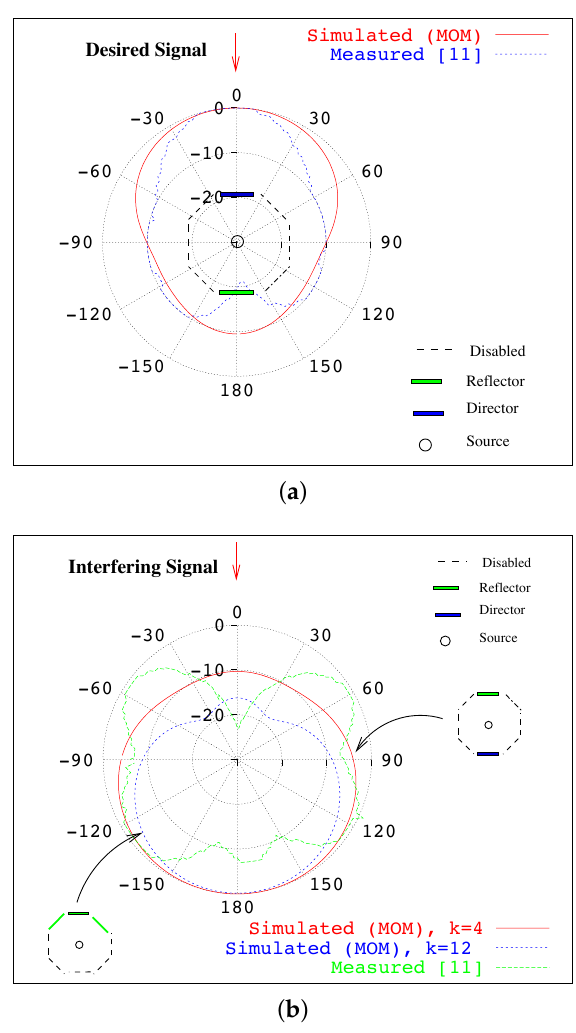
Figure 9. Numerical assessment. Direction of arrival identification, ( a ) desired and ( b ) interfering signal ( Φ = 90 ) . Beam pattern along θ = 90 plane.